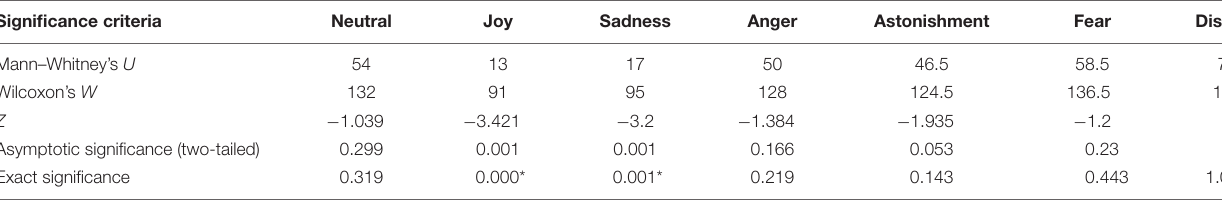
TABLE 3 | Comparison of gender subgroups by the basic emotions. Significance criteria